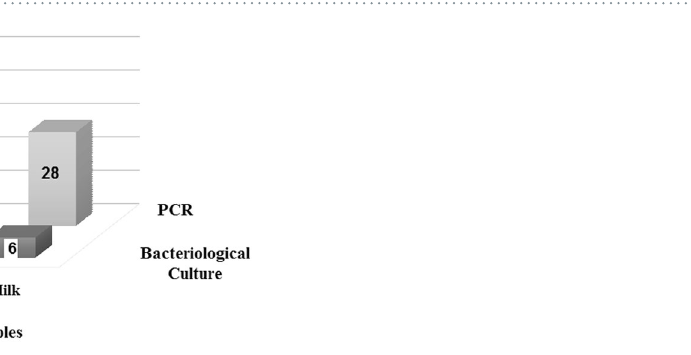
Table 3. Genotype combinations of Helicobacter pylori in PCR positive samples. n, means negative.